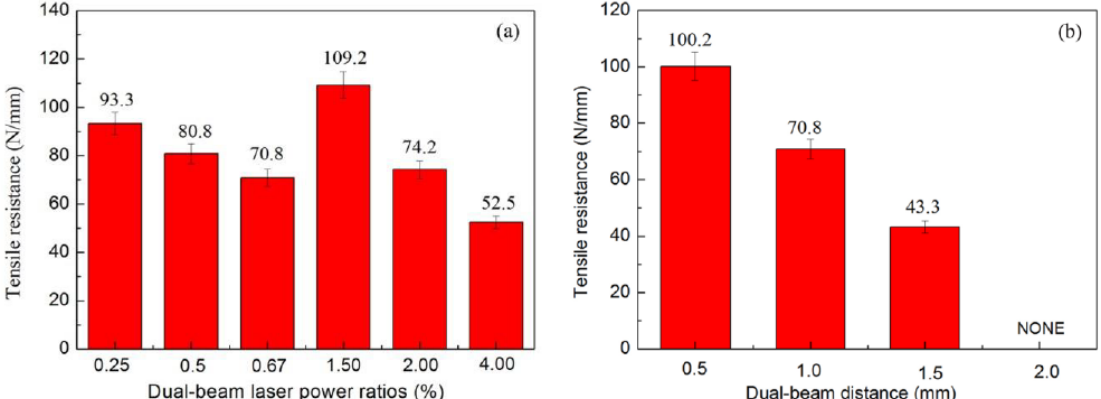
Figure 8. Effect of processing on tensile resistance of the steel/Al joints produced by dual-beam laser welding with side-by-side configuration: ( a ) dual-beam laser power ratios (%), ( b ) dual-beam distance (mm) [29].